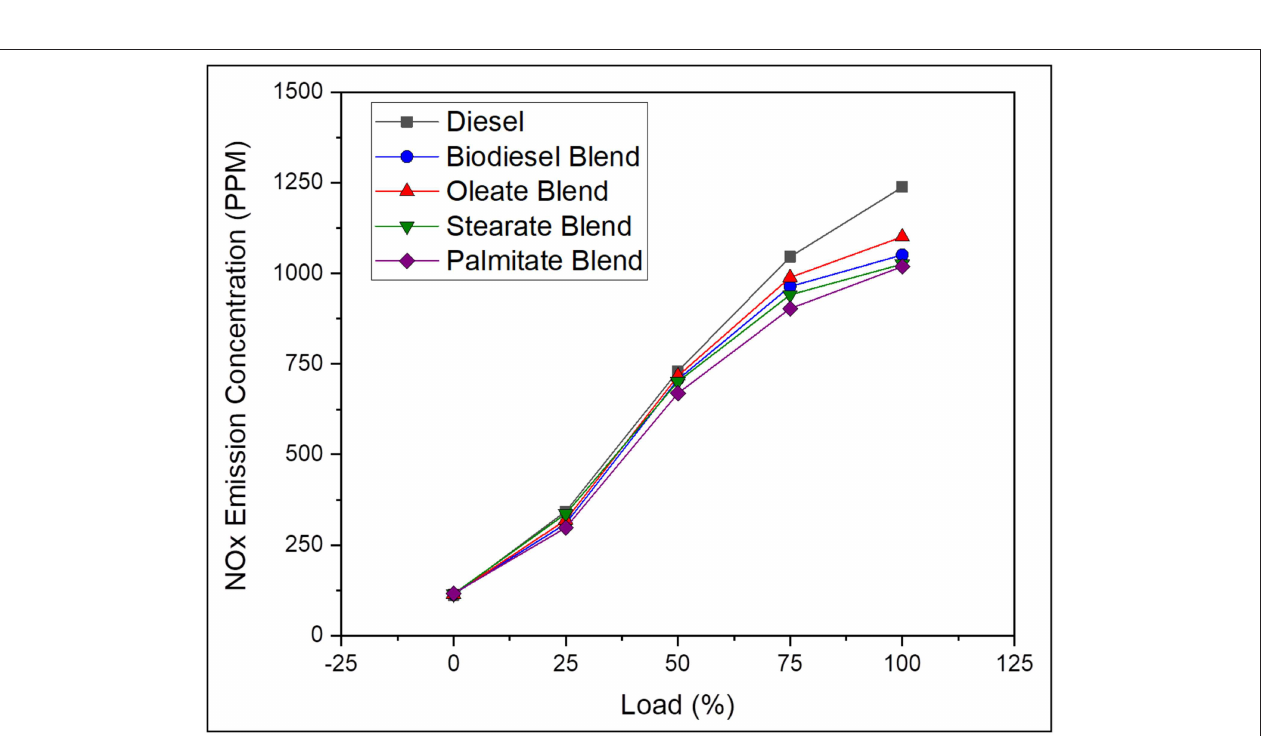
FIGURE 7 | NO x concentration of diesel and blend samples for varying load